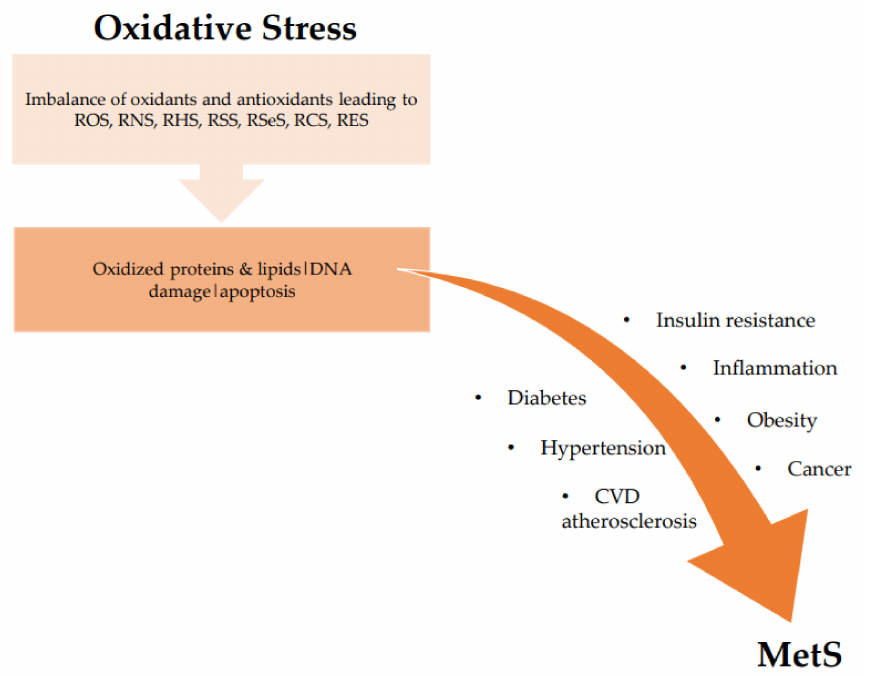
Figure 2. Association between oxidative stress and MetS. ROS: reactive oxygen species; RNS: reactive nitrogen species; RHS: reactive halogen species; RSS: reactive sulfur species; RSeS: reactive selenium species; RCS: reactive carbonyl species; RES: reactive electrophile species; CVD: cardiovascular